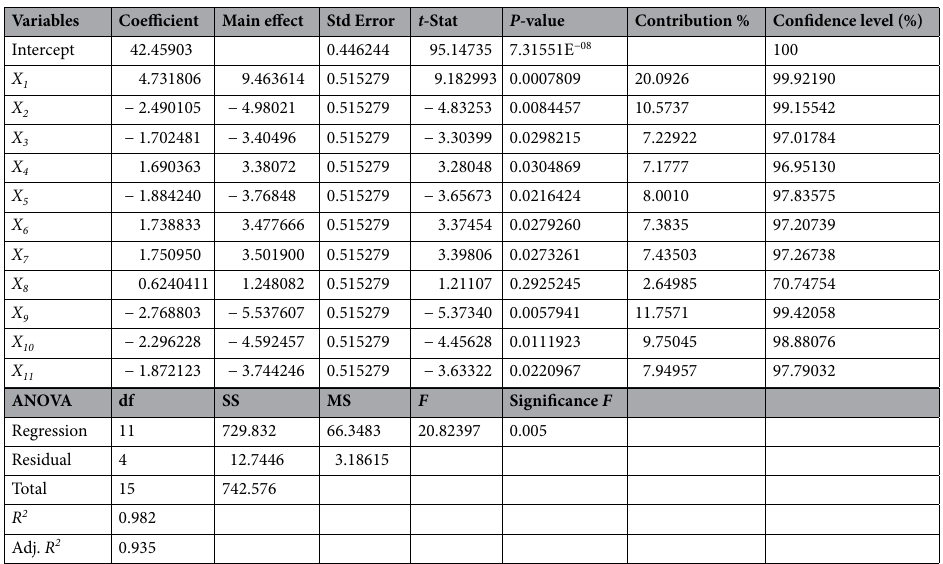
Table 2. Statistical analysis of Plackett–Burman design showing coefficient values, t - and p -values for each variable affecting ACP